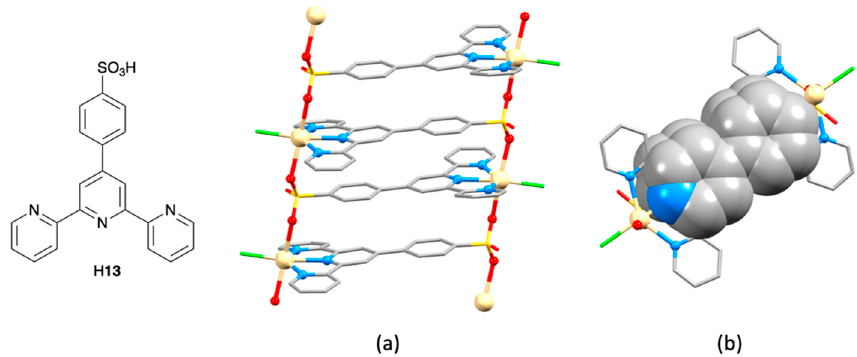
Figure 10. The structure of H 13. ( a ) Part of the 1D-ladder in [Cd( 13 )Cl] n (CSD refcode ZIQGUD) and ( b ) space-filling representation of the phenylpyridine units which are stacked in a head-to-tail arrangement down the ladder.